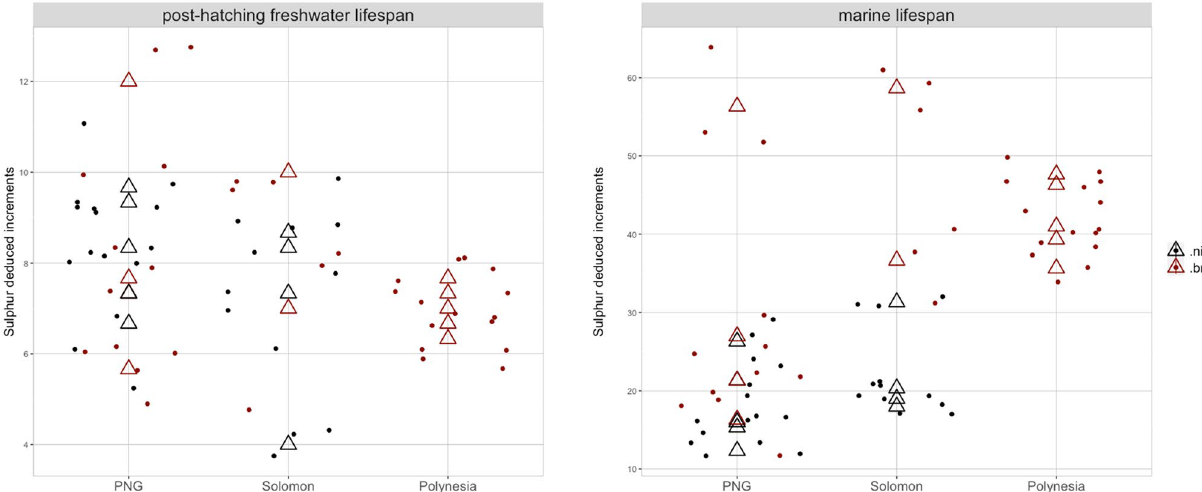
Figure 6. Plot summarizes the individual increment counting deduced from the sulphur (S) trace (three replicates in each sample) along their post hatching freshwater downstream migration (left) and their spreading time span within sea water environment (right) for each locality and species. (.ni): Microphis nicoleae ; (.br): Microphis brachyurus